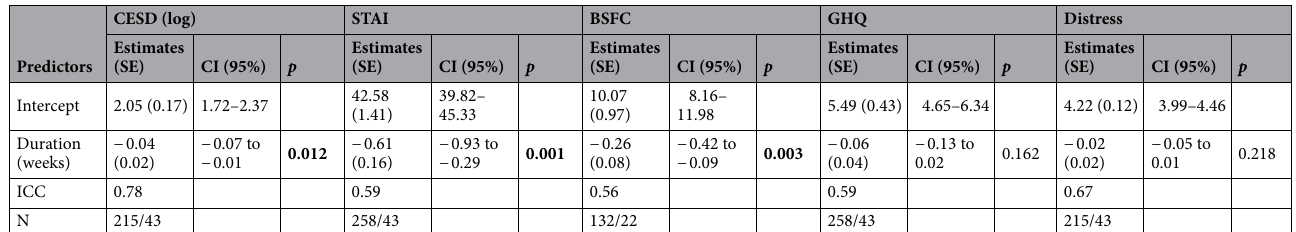
Table 2. Linear mixed models in adults estimating the effect of time after Covid-19 onset on mental health indices. CESD center of epidemiologic studies depression scales, STAI state and trait anxiety inventory (state anxiety sum scores), BSFC‑s burden scale for family caregivers (sum score), GHQ General Health Questionnaire (sum score), Distress modified Kessler psychological distress scale (mean), SE standard error, CI confidence interval, Duration (weeks) fixed effect, weeks passed since restrictions have been introduced, ICC intraclass correlation coefficient, N number of observations)/(number of participants), p values have been estimated using Satterthwaite approximation, significant effects in